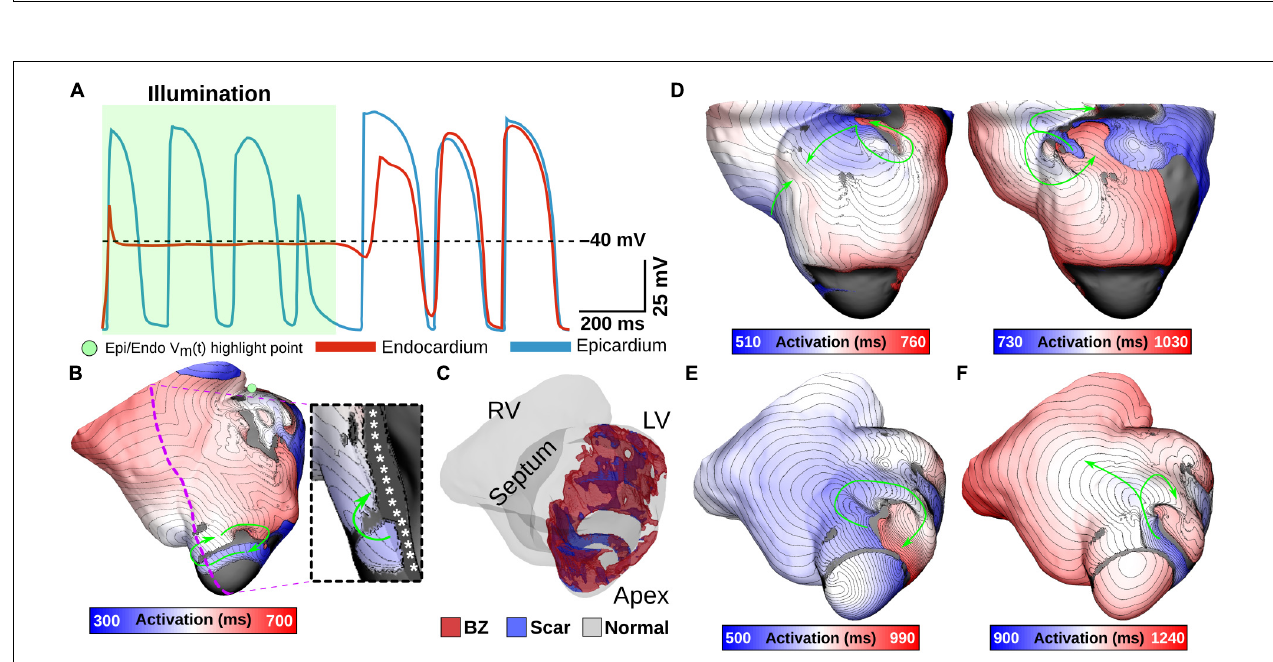
FIGURE 8 | Examining low optogenetic defibrillation success rates in V02. V m (t) traces (A) and an activation map (B) showing an example of GtACR1-based defibrillation failure (E e = 1 mW/mm 2 ). Green shaded region in (A) shows illumination interval. Excitation is silenced at the endocardium, but arrhythmia persists at the epicardium (inset) due to a protected VT circuit created by a particular geometry of BZ and scar (C) . (D) Representative examples to illustrate differences between destabilized reentrant circuits in GtACR1-expressing defibrillation failures (E e = 5 mW/mm 2 and E e = 10 mW/mm 2 ). (E,F) Example of defibrillation success (ChR2-RED, E e = 5 mW/mm 2 ) showing a normal cycle (E) and cycle with conduction block near LV apex (F) that leads to termination. Arrows indicate wavefront propagation.